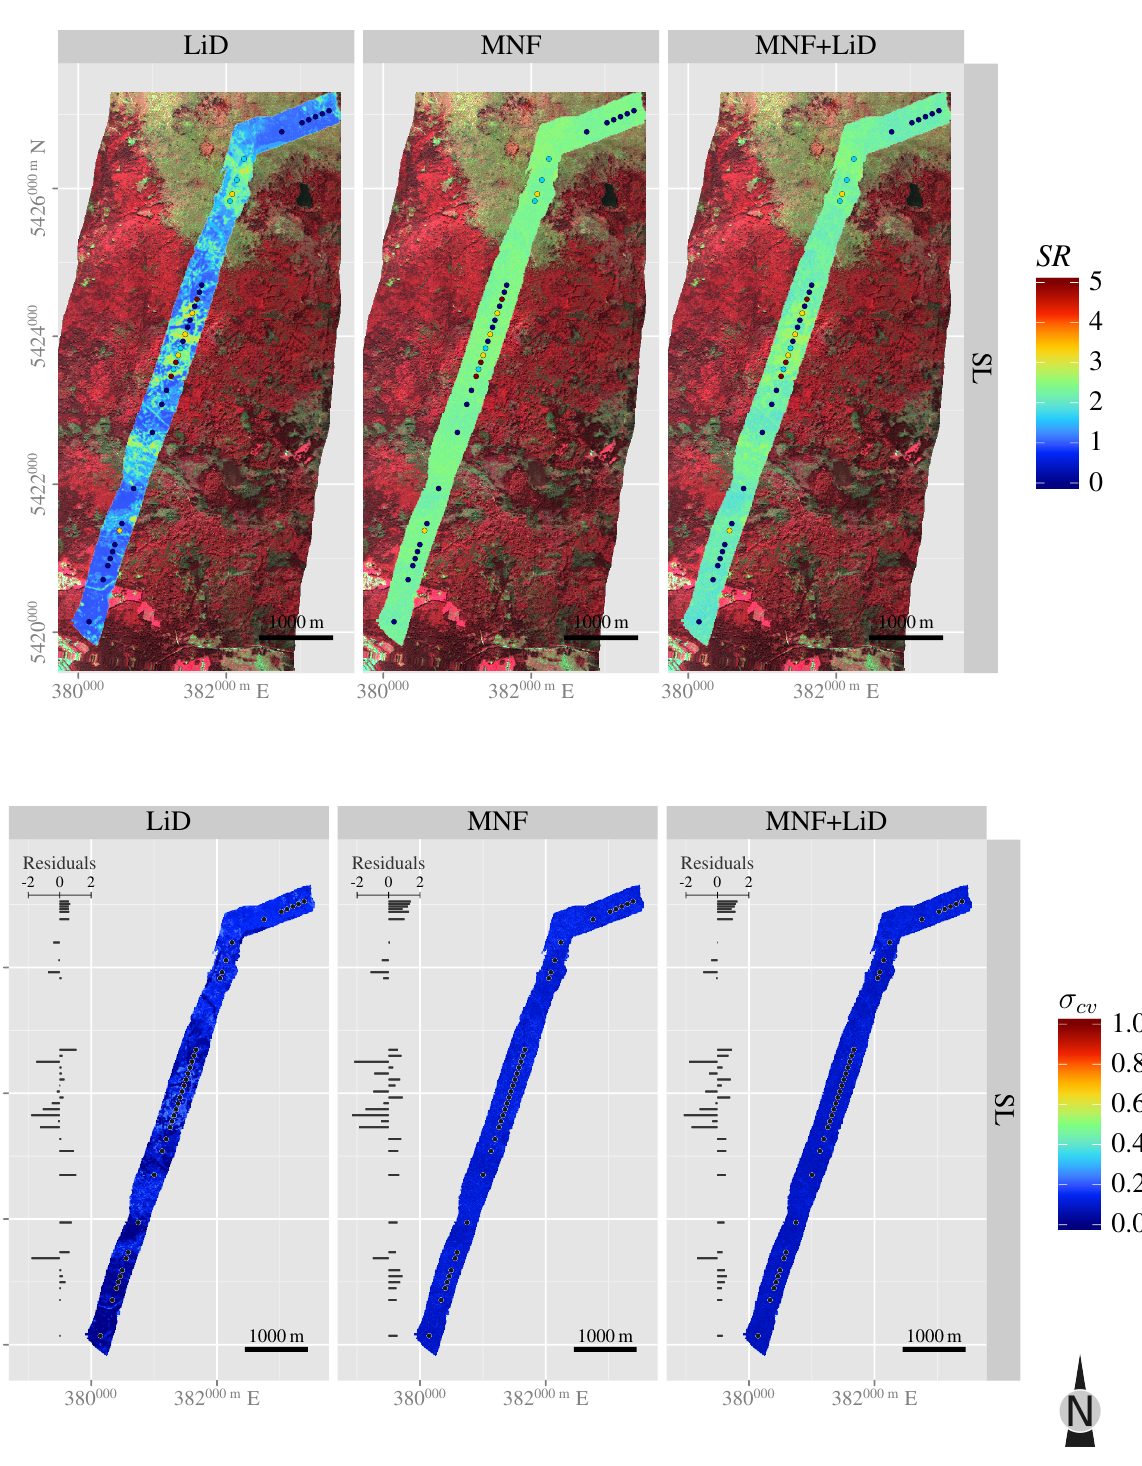
Figure 6. Predicted species richness of the shrub layer (SL) for the LiDAR (LiD) and hyperspectral (MNF) predictor sets and their combination (MNF+LiD). Upper panel: averaged predictions of ten cross-validation models and plot information used to train and evaluate the random forests. Background: color-infrared composite of the HyMap data. Lower panel: standard deviation of the predictions of the ten cross-validation models. Bar charts show the residuals between predicted and observed estimates in cross-validation. Positive residuals are due to an overestimation by the model and vice versa .